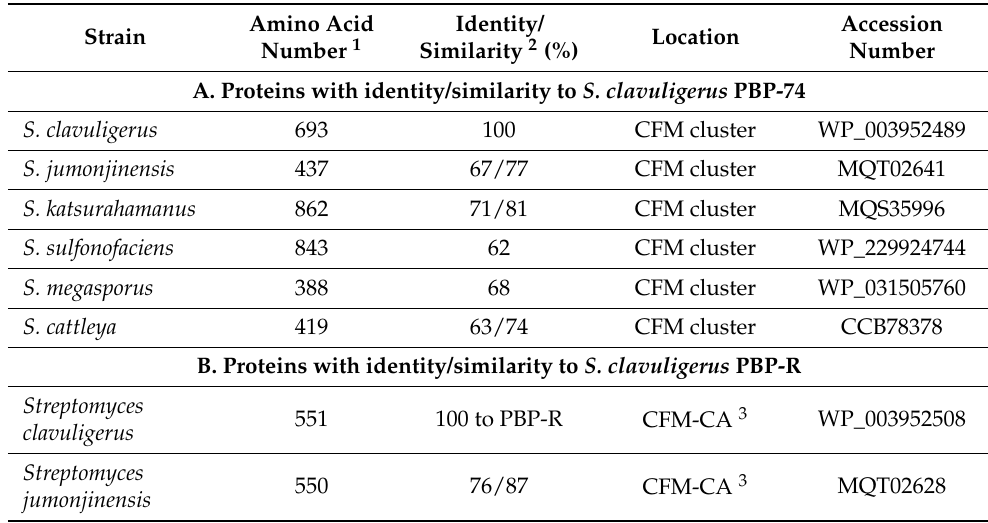
Table 2. Genes encoding PBPs located in actinobacteria β -lactam gene